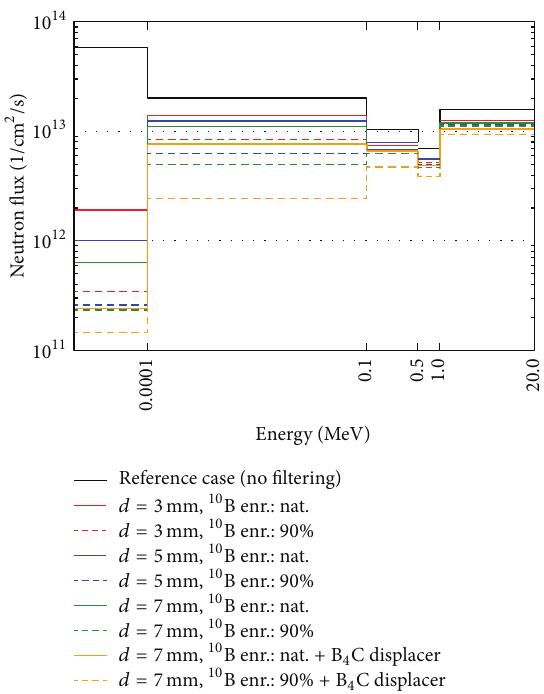
Figure23:Thespectruminthewholevolumeoftheirradiationtube for each case [17]. Figure 24: The multigroup flux—corresponding to the 10MW thermal power of the BRR—in the whole volume of the irradiation tube for each case